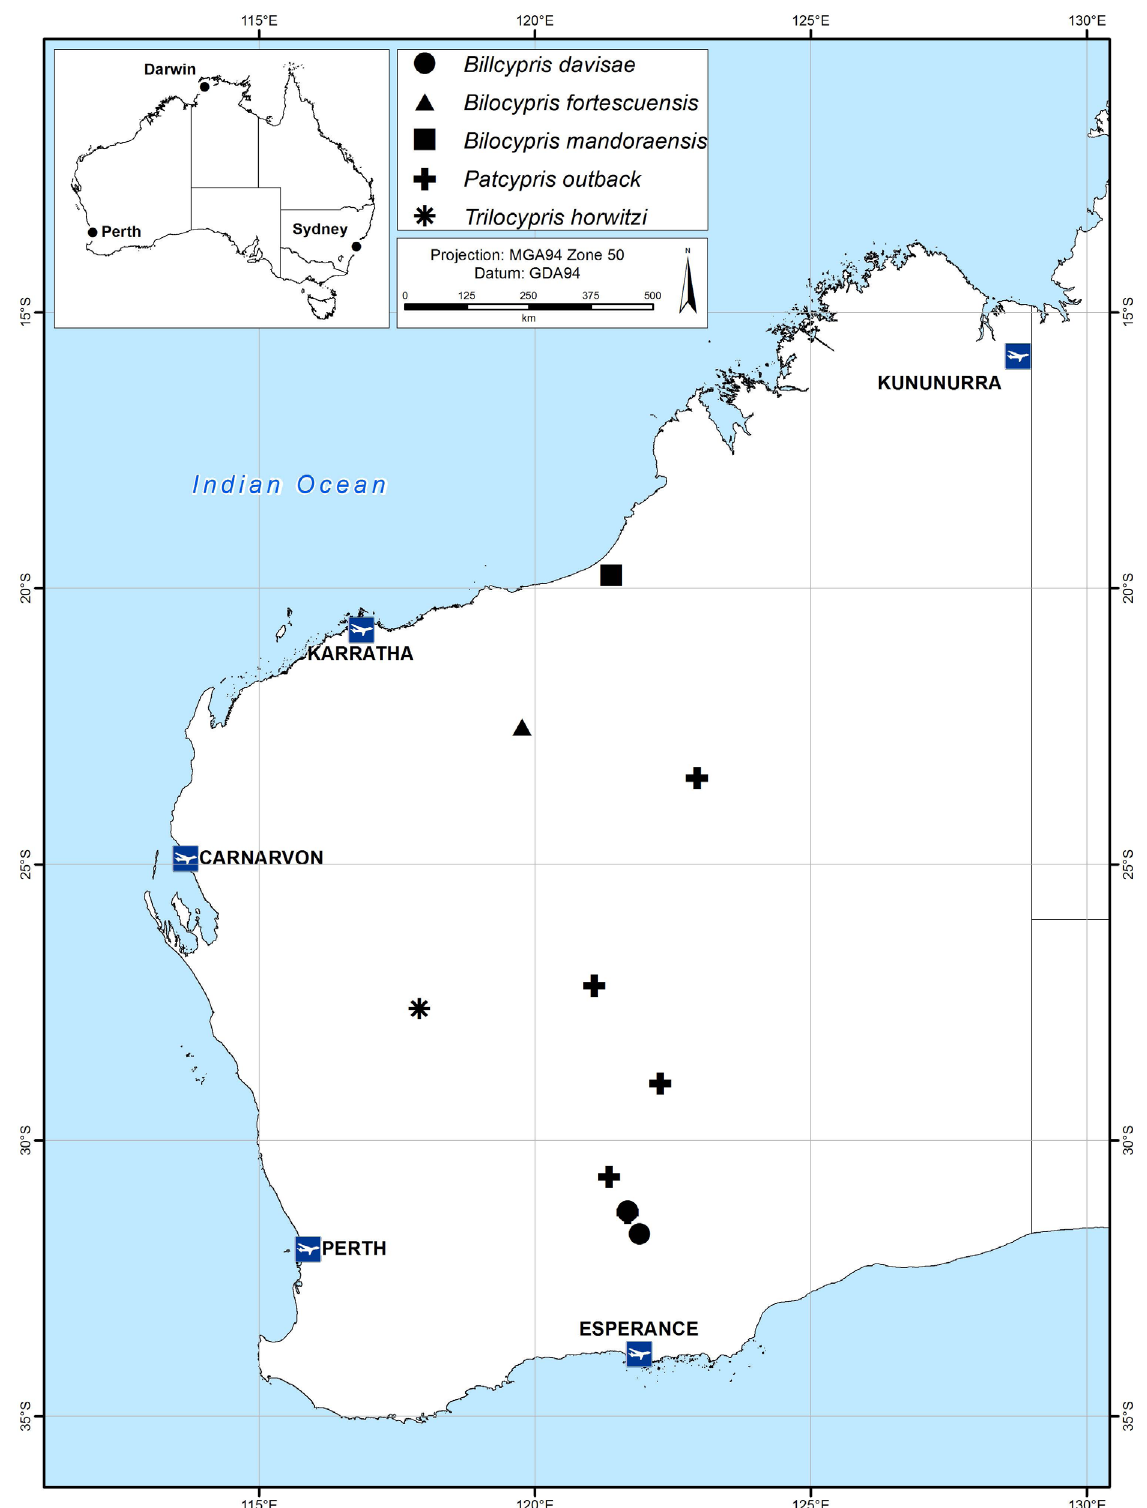
Fig. 1. Map of Western Australia, showing localities where the new species were